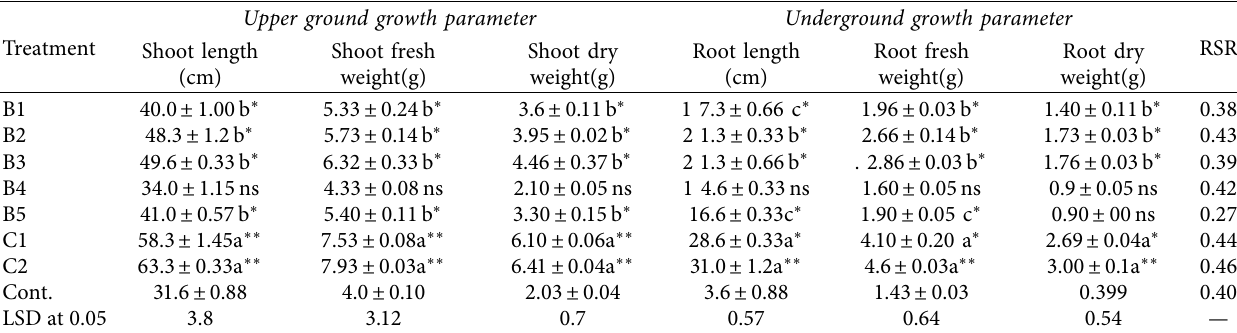
Table 5: The effect of Bacillus and Cyanobacteria on the growth of Rice Cv. Edget seedlings. Treatment